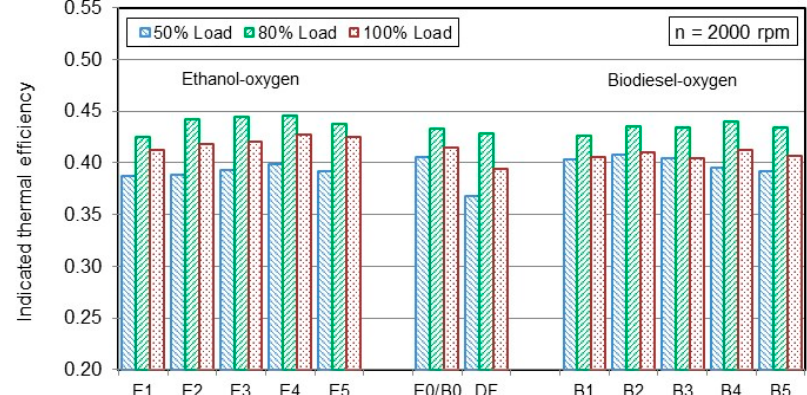
Figure 11. Indicated thermal efficiency (ITE) as a function of ethanol–oxygen or biodiesel-oxygen mass content (wt%) in fuel blends for medium (50%), intermediate (80%) and full (100%) loads corresponding to the respective IMEPs of 0.75, 1.20, and 1.50 MPa developed at maximum torque speed of 2000 rpm.